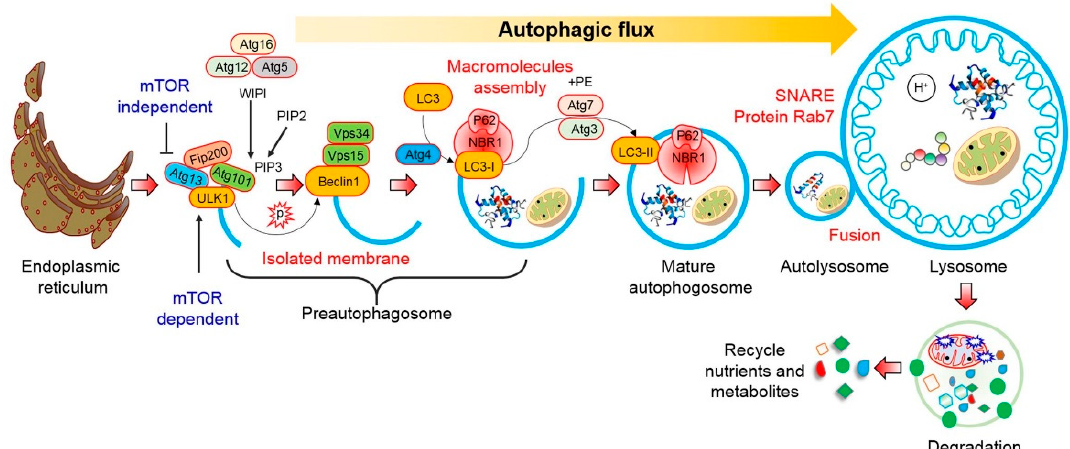
Figure 1. Schematic diagram of different steps of autophagy. Autophagy is initiated by inactivation of the mTOR pathway and induction of numerous autophagy-related proteins. Pre-autophagosome synthesis involves the coupling of LC3 with ULK1 and Vps34 proteins. Importantly, AMPK-mTOR signaling are involved to initiate pre-autophagosome or phagosphore formation. Sometimes, mTOR independent pathways are associated to initiate phagosphore formation. Subsequently, the pre-autophagosome forms the double membrane vesicle that sequesters cytoplasmic contents and forms the mature autophagosome. Finally, the mature autophagosomes fuse with the lysosomes wherein the contents are degraded and recycled back into the cytoplasm which may further be used as nutrients.